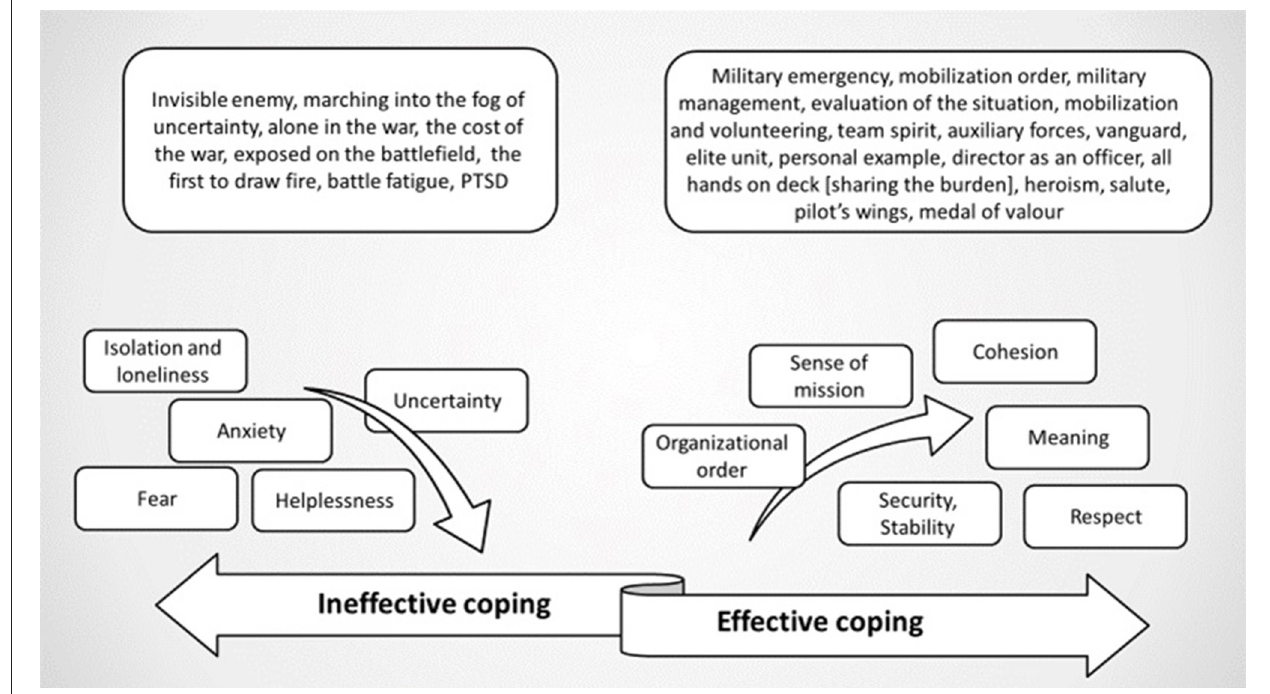
FIGURE 1 | Effective and ineffective coping